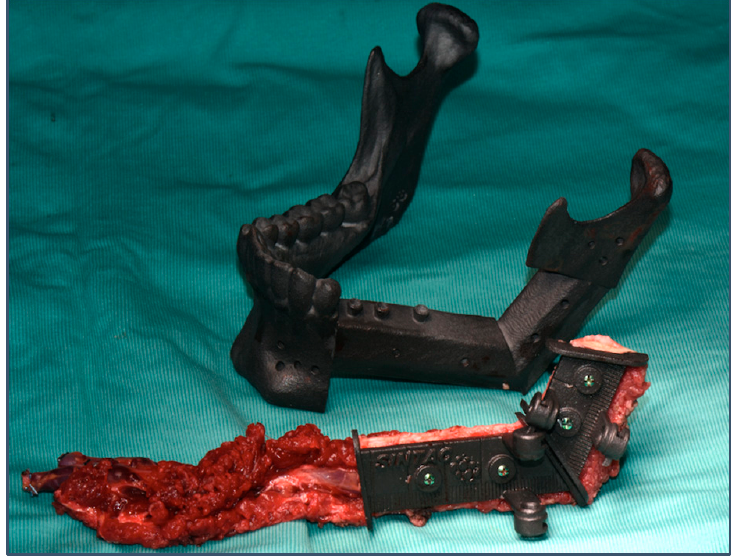
Figure 3. Free fibula flap consisting of two bony segments. The flap is compared morphologically with the 3D model of the mandibular reconstruction.